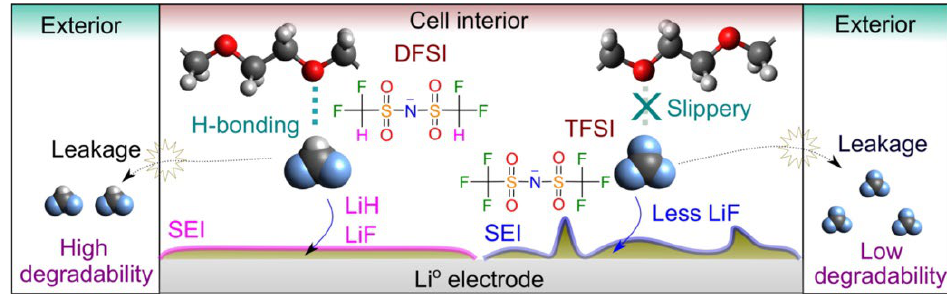
Figure 1. Comparison between the chemistry of CF 2 H- and CF 3 -containing compounds inside and outside a Li-metal cell. The light grey, grey, red, and light blue balls represent H, C, O, and F atoms, respectively. Reproduced with permission from ref. [14]. Copyright 2020 Elsevier.